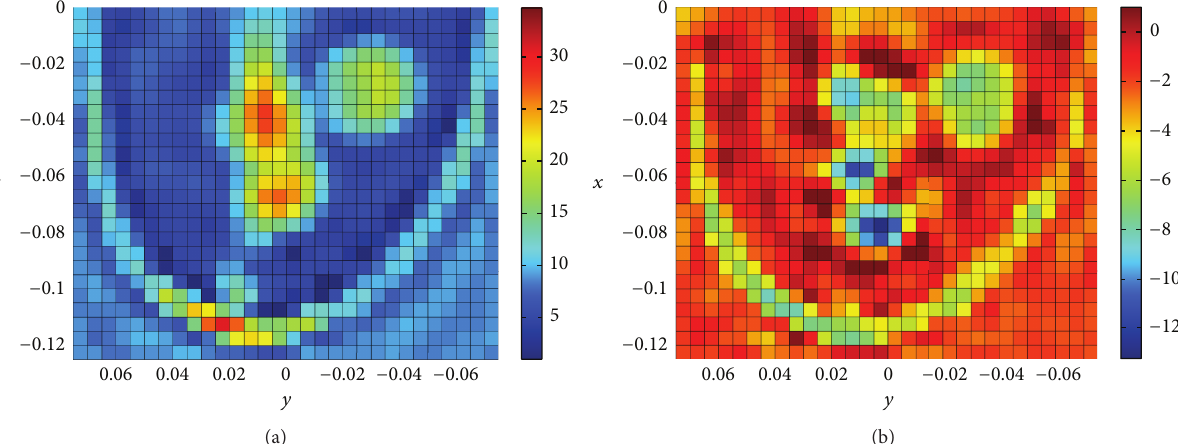
Figure 16: The reconstructed permittivity in a sagittal slice at 𝑧 = 0 . Real part (a) and imaginary part (b). Distances are in m.